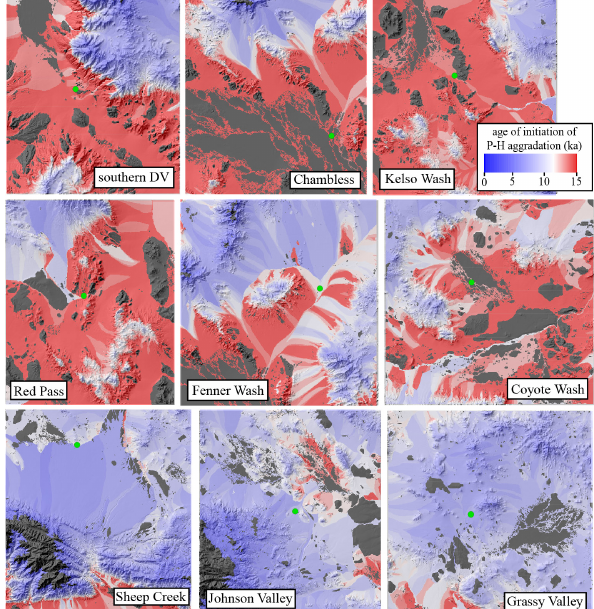
Figure 6. Subsets of Fig. 4 shown in greater detail and overlain on a shaded-relief image for each of the nine areas where the timing of fan aggradation is reasonably well constrained. Study areas are shown as lowest to highest elevation (of the dated sample locations) from upper left to lower right. The predicted age of initiation oc- curs systematically later at higher elevations, as also documented in Table 1 and Fig. 7.